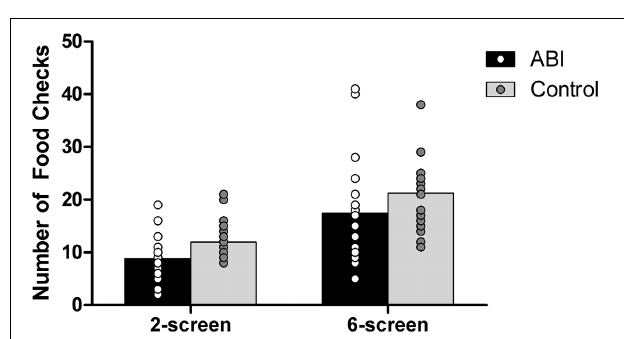
FIGURE 9 | Number of table settings.